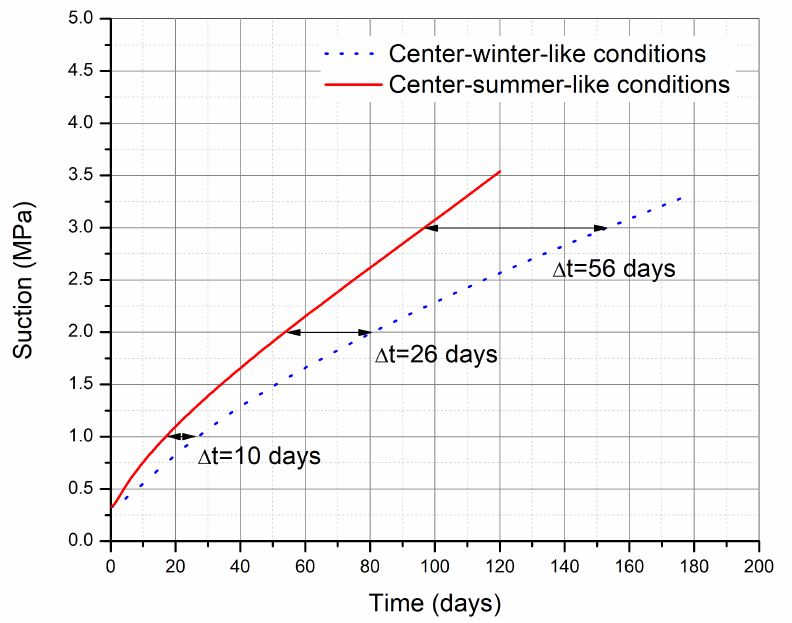
Figure 16. Comparison of suction evolution at the critical point (at the center) for summer-like and winter-like environmental